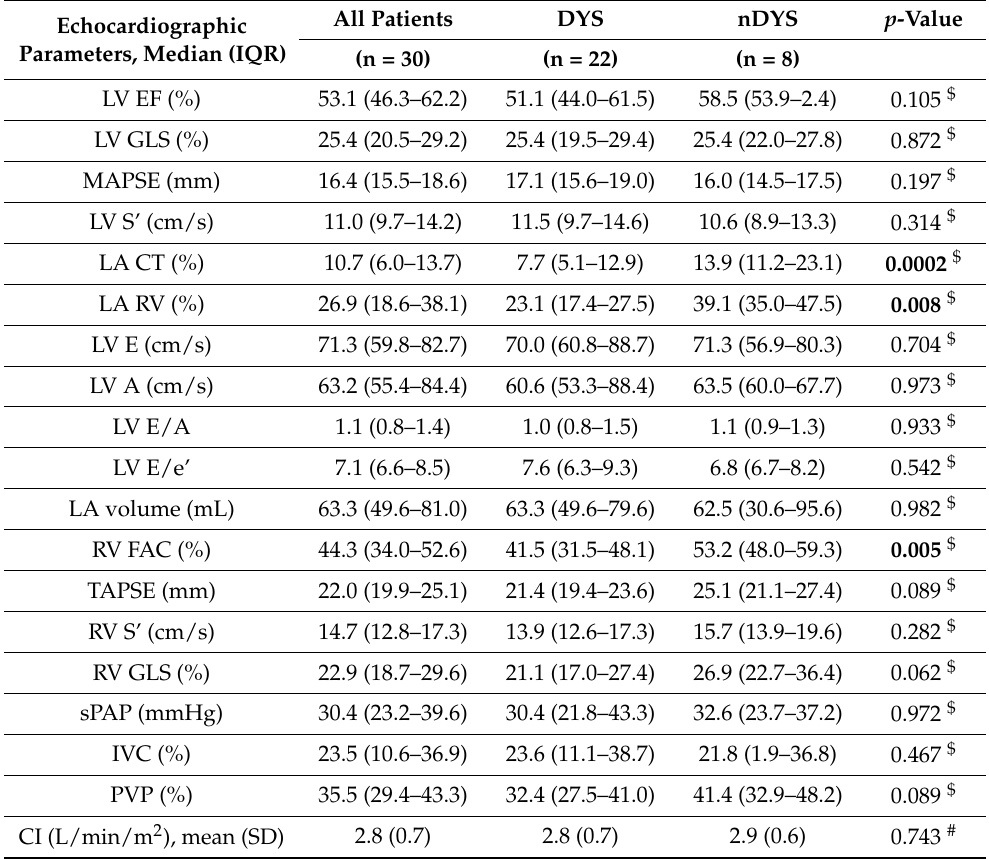
Table 2. Echocardiographic evaluation of patients with (DYS) and without (nDYS) cardiac dysfunction at ICU